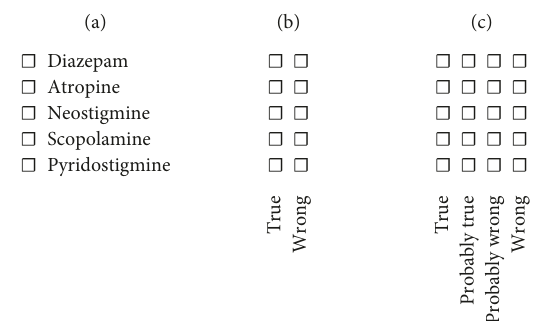
Figure 3: Examples of MC, MTF, and R4 question types. A sample question with its five alternatives and the three implementations of the key used in 2013 (all) and 2014 (only panel). (c): Students were asked to check true alternatives and leave false alternatives blank (MC, panel (a)), to indicate for each alternative whether it is true or false (MTF, panel (b)), or to rate each alternative on a 4-point scale (R4, panel